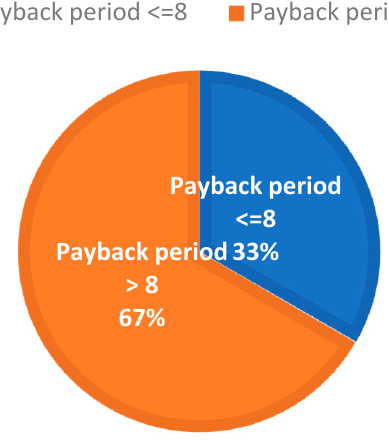
Figure 15. Percentage of regions with payback year.